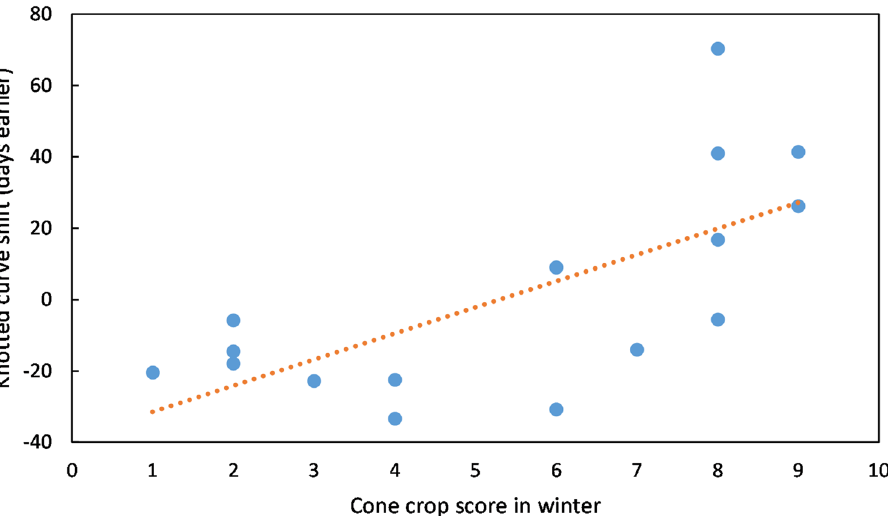
Figure 5. Crop cone impact on timing of fledging. Number of days earlier in the year that the spike in fledgling abundance occurred as a function of cone crop score in the previous winter. Data for 2005–2020. R 2 =